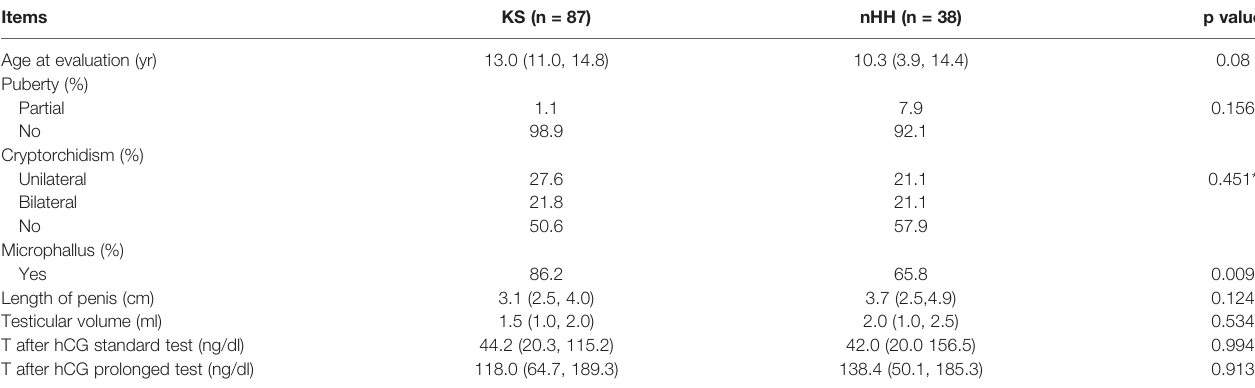
TABLE 2 | Baseline clinical characteristics of 125 pediatric patients with CHH.